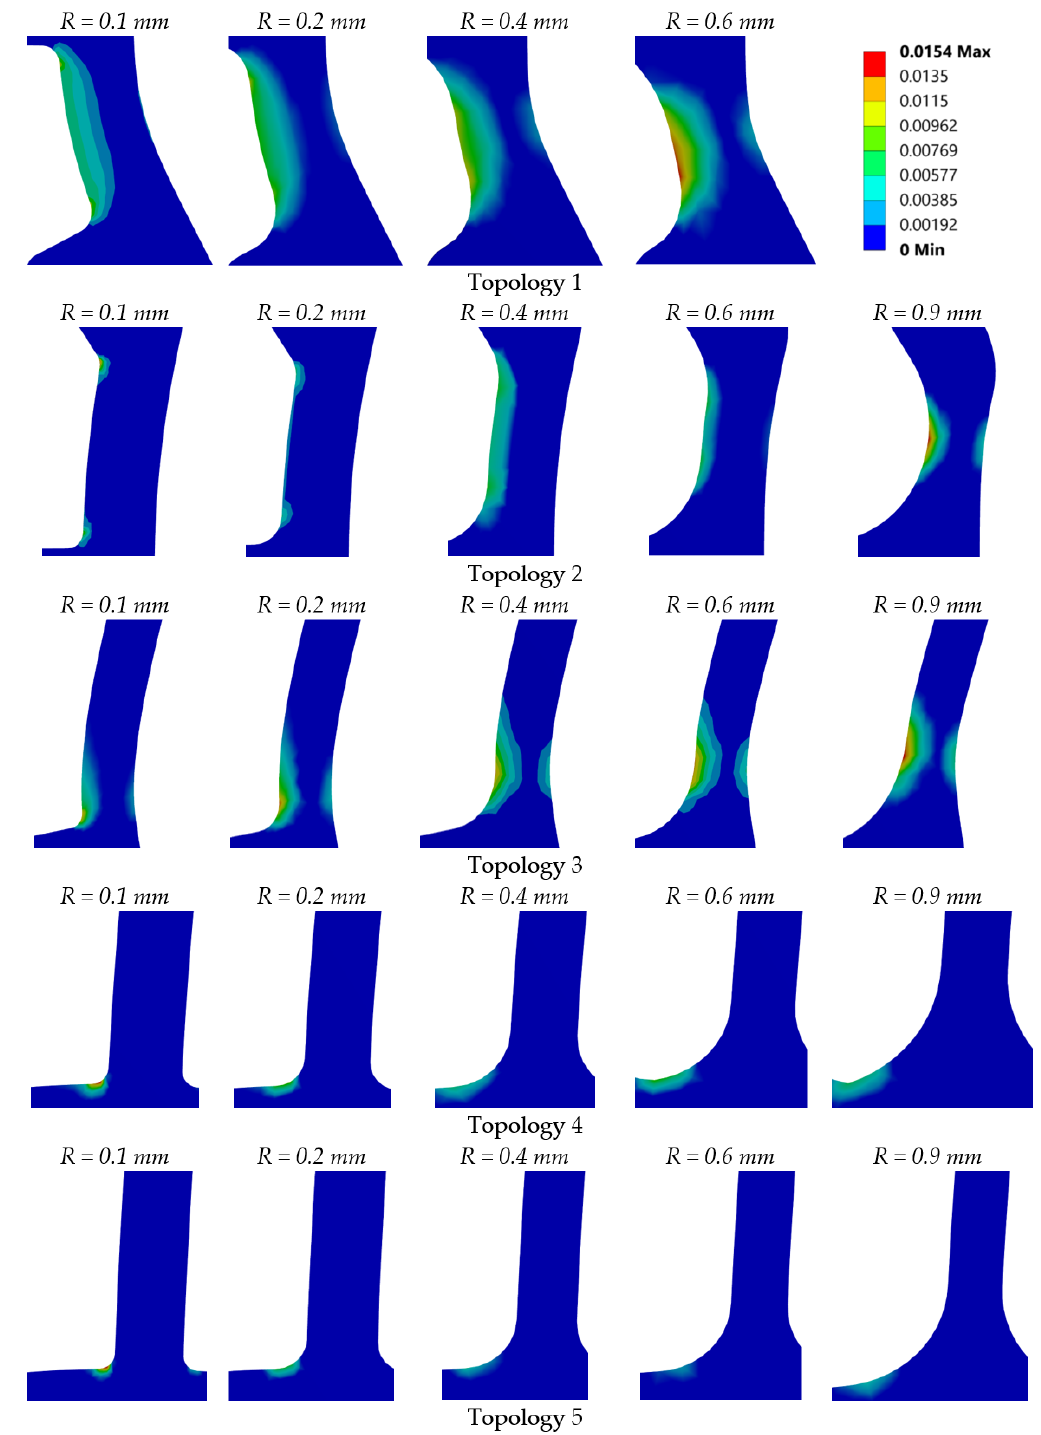
Figure 10. Equivalent plastic strain for different fillet radiuses.